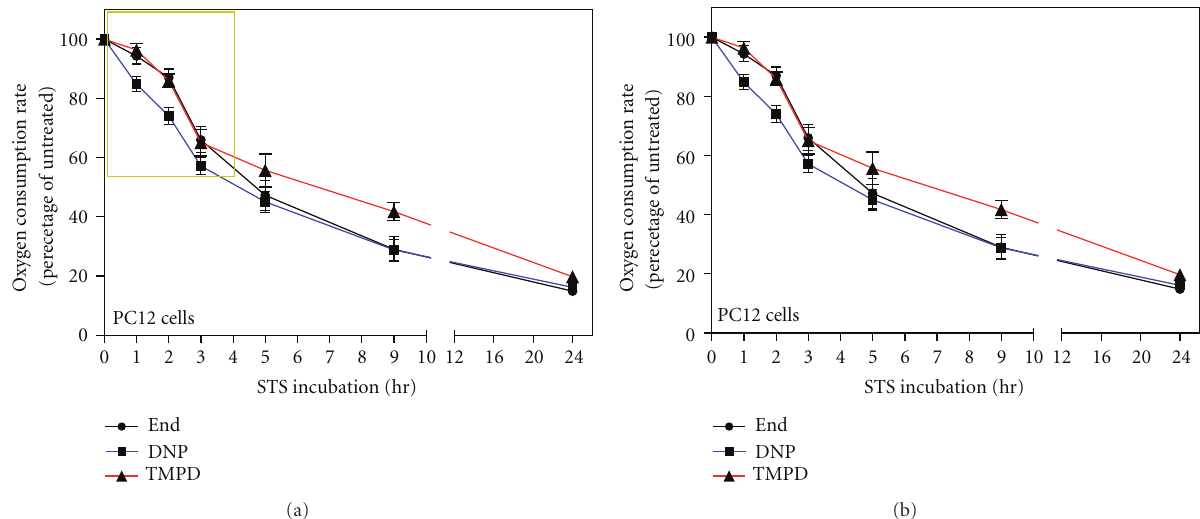
Figure 1: Decrease in endogenous, DNP-uncoupled, and TMPD-dependent respiration rates in intact PC12 cells treated with STS; early decrease in DNP-uncoupled respiration. (a) Oxygen consumption rates of 2 μ M STS-treated PC12 cells measured at the indicated time points. Oxygen consumption rates were measured in TD bu ff er (endogenous respiration, End), in TD bu ff er containing DNP (DNP- uncoupled respiration, DNP) and in TD bu ff er containing DNP, antimycin A, ascorbate, and TMPD (TMPD-dependent respiration, TMPD). Data are expressed, at each time point, as percentages of the oxygen consumption of untreated cells (0hr). To reduce the variability of the experiments we calculated the percentages with respect to the control of that particular experiment, and then we averaged the percentages. Data are expressed as means ± SE (standard error) with n varying at each time point and being 31, 16, 9, 6, 7, 2, and 7, respectively, for the indicated time points (1h, 2 h, 3h, 5h, 9h, 24h). (b) Magnification of (a) area surrounded by a yellow frame. Note that the ordinate scale starts at